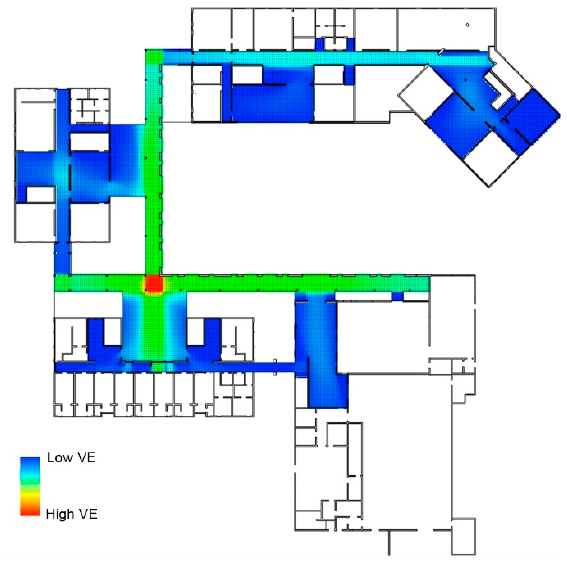
Figure 3. The distribution of the VE value in the special primary school.